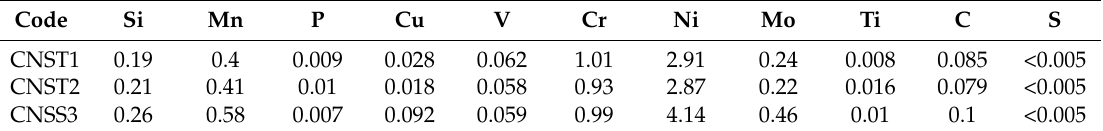
Table 1. The chemical composition of CNST1, CNST2 and CNSS3 steels (mass fraction, %).